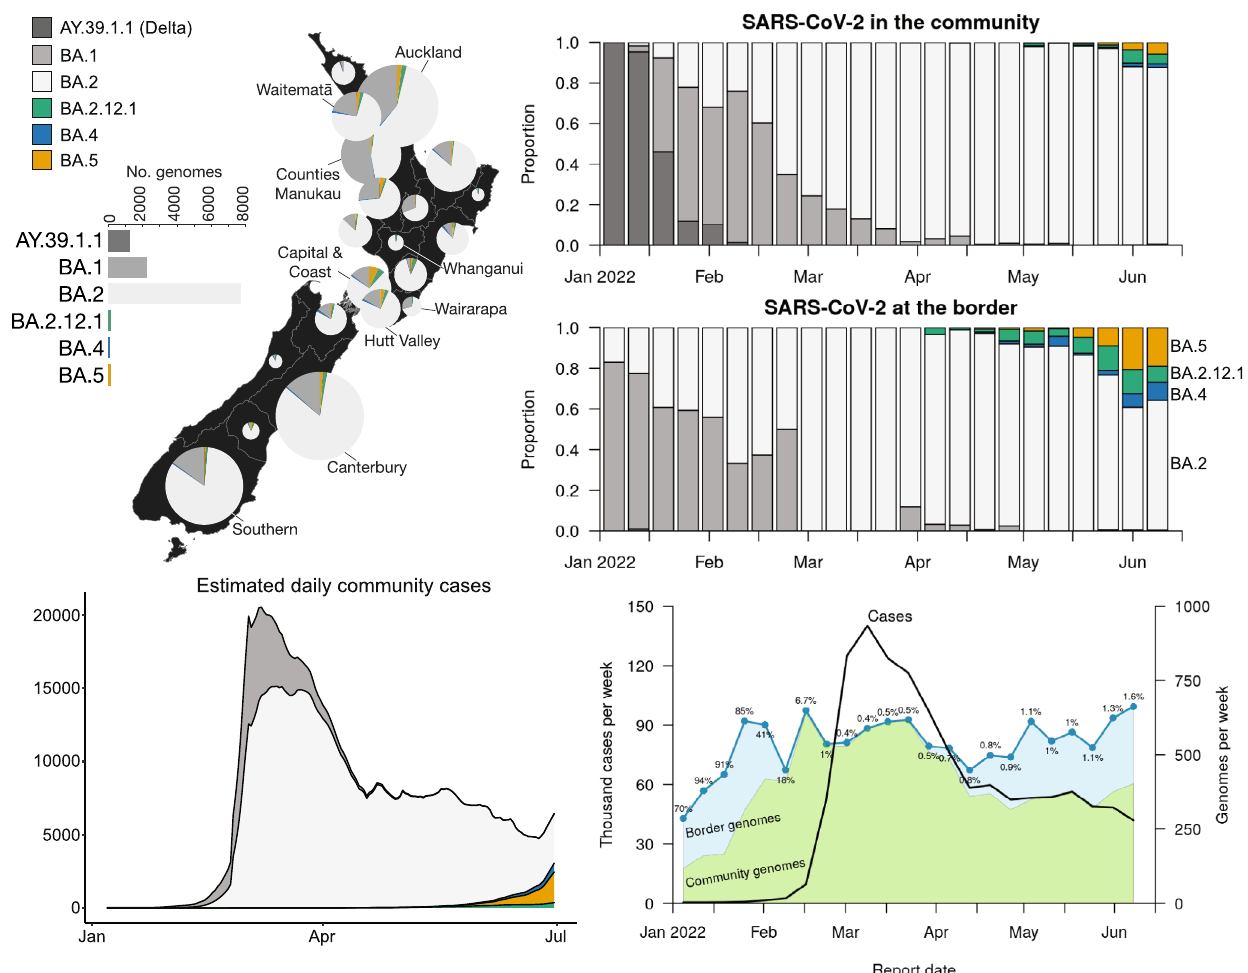
Fig. 2 | Summary of Omicron genomic sequencing. Top left: Omicron variant distribution by New Zealand district health board, for cases reported between 8 Dec 2021 and 15 June 2022. The Delta lineage (AY.39.1.1) is omitted from the map. Top right: New Zealand genome sequencing, coloured by lineage. A border case is one either in managed isolation after arriving in New Zealand (MIQ (managed isolation and quarantine)era),orone with overseastravel history in the past seven